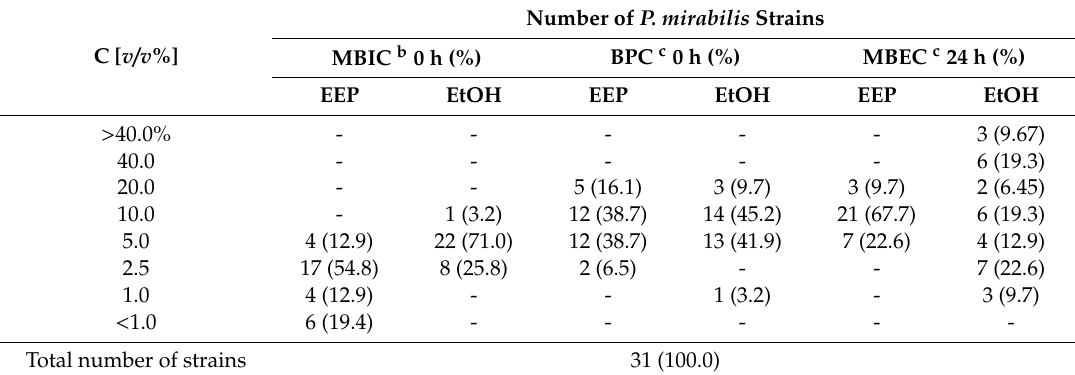
Table 2. Comparison of Proteus mirabilis a susceptibility to Manuka honey (MH). Number of P. mirabilis Strains (%) MH Concentration ( v / v %) MBIC b 0 h BPC c 0 h MBEC c 24 h > 30.0 0 (0.0) 11 (35.5) 31 (100.0) 30.0 28 (90.3) 20 (64.5) 0 (0.0) 20.0 3 (9.7) 0 (0.0) 0 (0.0) 15.0 0 (0.0) 0 (0.0) 0 (0.0) Total number of strains 31 (100.0) 31 (100.0) 31 (100.0)